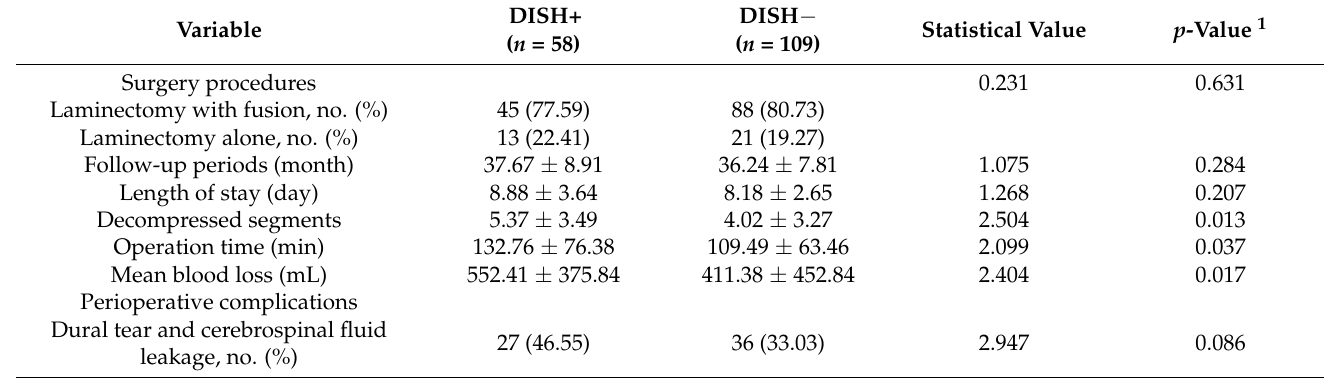
Table 4. Perioperative information of patients between the DISH+ and DISH − Group. Subjects were treated by two different techniques of posterior thoracic decompression: laminectomy alone and laminectomy with posterior instrumentation and fusion. Of all included patients, 34 patients underwent laminectomy alone, while 133 patients were treated by laminectomy with posterior instrumentation and fusion. All surgery-related events that occurred within 30 days of the operation were defined as perioperative complications, mainly including dural tear and cerebrospinal fluid leakage, neurologic deterioration, surgical site infection and